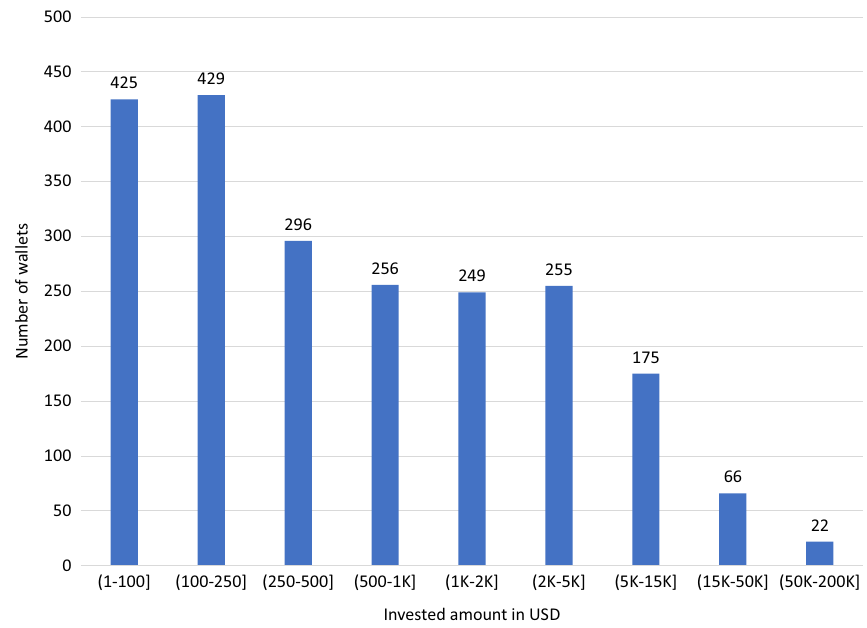
Fig. 4 Histogram of the invested amount (in USD) per portfolio. Figure based on data from March 2021. Contains ownership of the 58 properties in Table